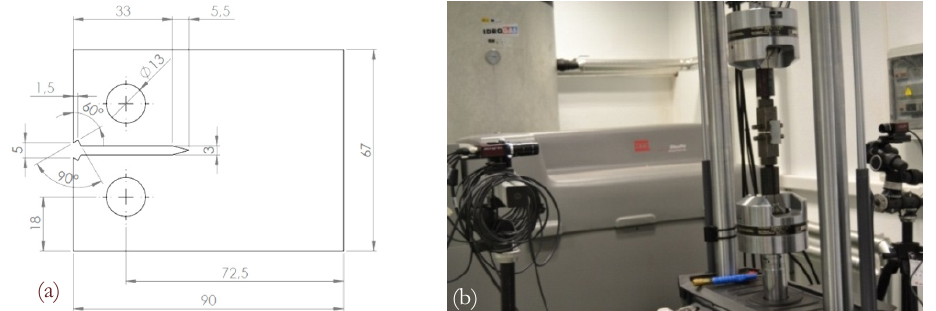
Figure 2: CT specimen (a) and experimental set-up (b) used for fatigue